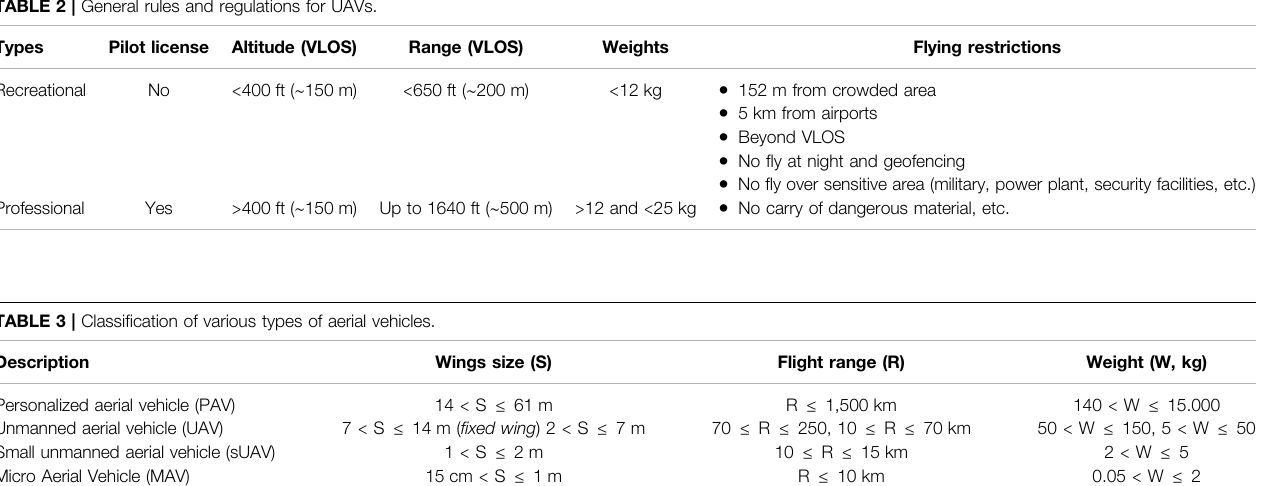
TABLE 2 | General rules and regulations for UAVs.